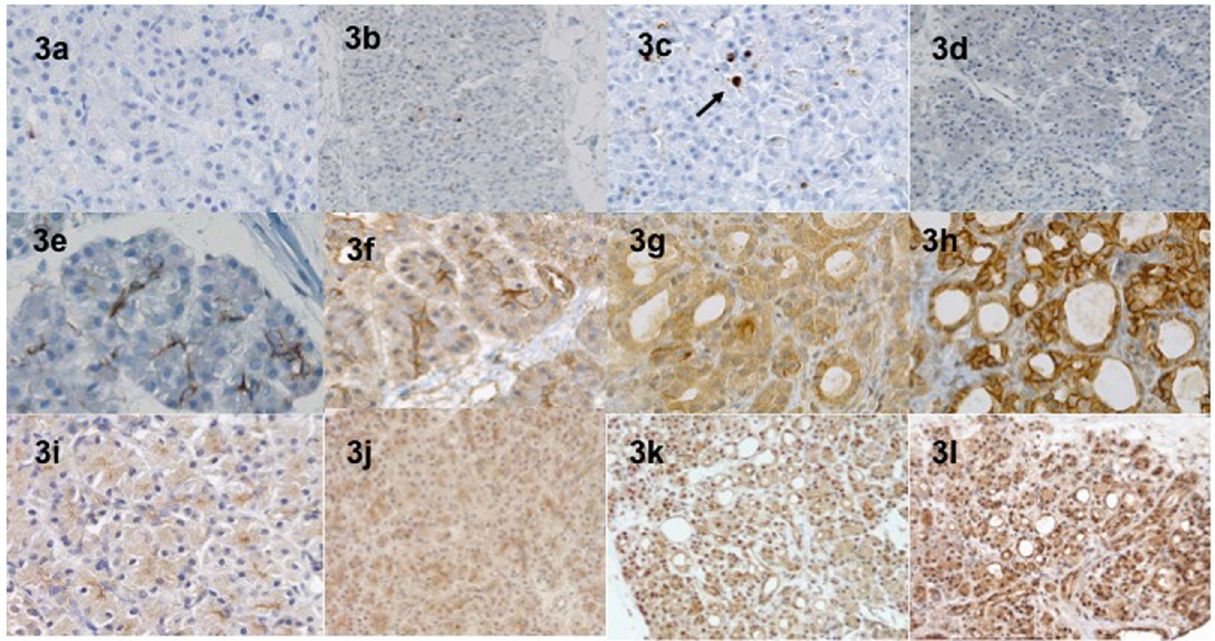
Figure 3. Immunohistochemical expression of caspase-3 antibody at baseline (a), H24 (3b), H48 (3c) and H72 (3d) in hyperoxic conditions. At H72 (3d), less than 5 cells per HPF expressed the caspase-3. Other types of cells (islets, ductal) did not express caspase-3 at any time. The membranous CA9 and the nuclear Hif-1α expression in acinar cells was studied at baseline (3e and 3i), H24 (3f and 3j), H48 (3g and 3k) and H72 (3h and 3l). The intensity greatly increased in dedifferentiated areas with a gradual